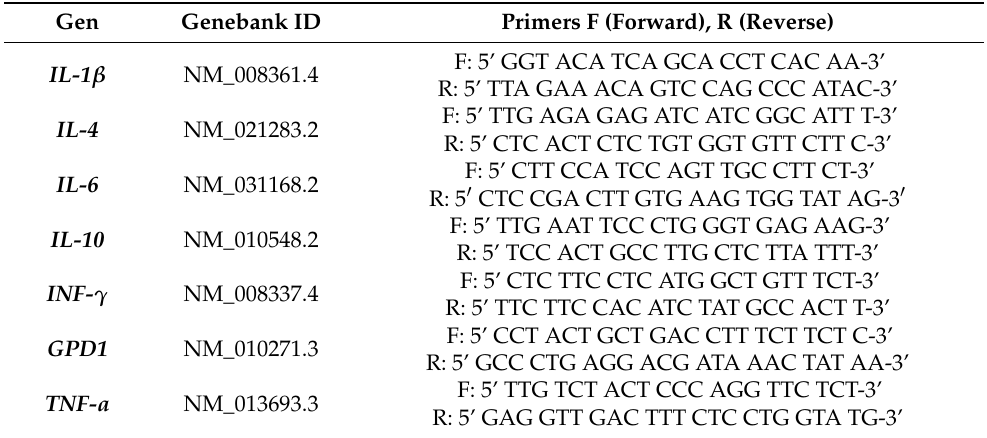
Table 1. Primer sequences used for qPCR amplification of the genes of interest and the accession numbers of the sequences used for their